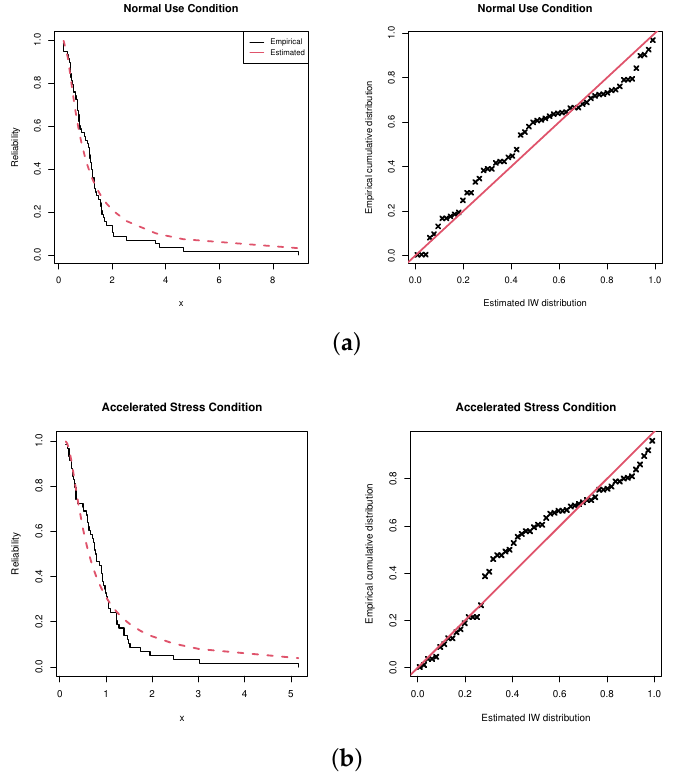
Figure 12. Estimated RF and PP plots for ( a ) Normal use condition and ( b ) Accelerated stress condition from LED data. Table 8. Different artificial APT-IC samples from LED